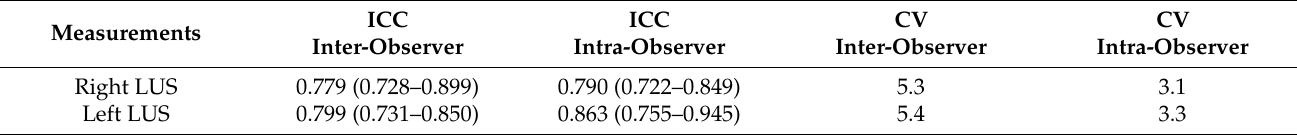
Table A4. Inter- and intra-observer reliability